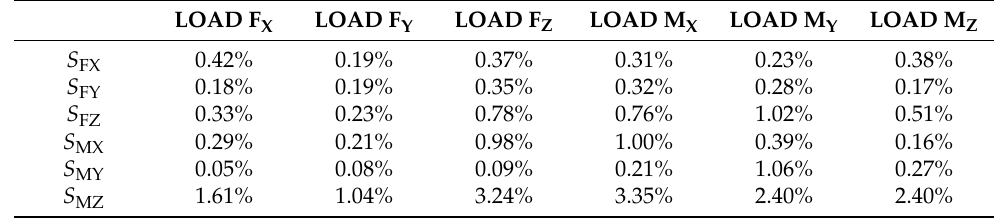
Table 9. Analysis of average measurement error and crosstalk of 24 strain gage